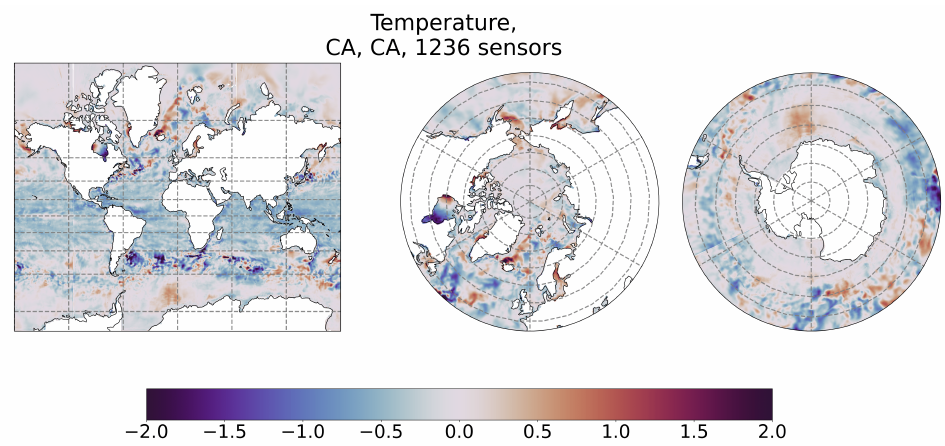
Figure 11. Spatial distribution of reconstruction bias by the Concrete Autoencoder (CA) from 1236